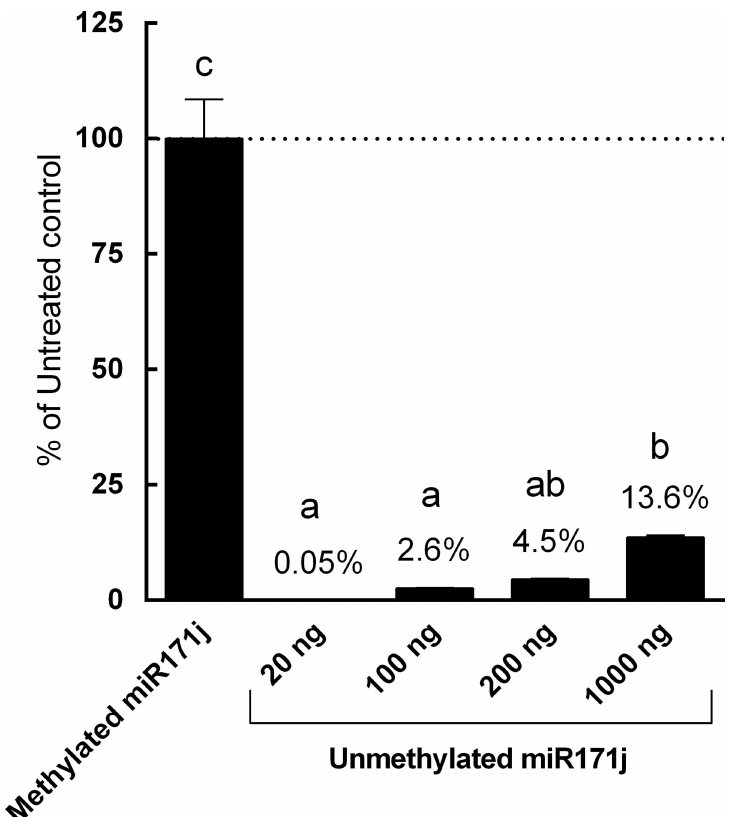
Fig 4. Concentration-dependent decreasein treatment efficiency of unmethylated miRNA. 20 ng of methylatedmiR171j or 20–1000 ng of unmethylated miR171jwere treated with or without periodate, followed by β elimination,and analyzedby qRT-PCR as describedin Materials and Methods. Data is presentedas a percentage of miR171jdetected in the treatment group to that of the control group. Columnsmarked with different letters are significantly different from each other ( p (cid:20) 0.05, data presented as Mean ± SD).